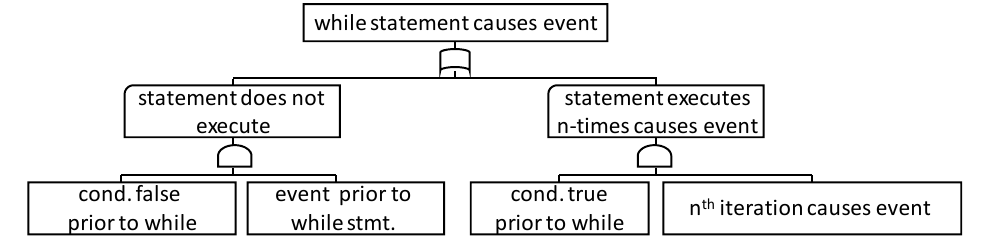
Figure 6. FTT for while statement.